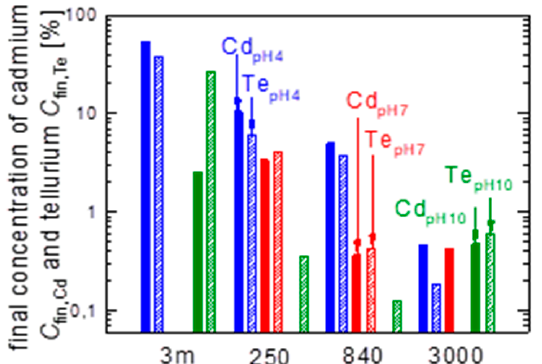
10 of 20 Figure 5. Elution of Cd pH10 and Te pH10 in solutions with pH10 out of CdTe powder and for milled module pieces. ( a ) The size dependent leaching of Cd pH10 changes when compared to the acidic elution in Figure 1. Here it holds Cd 3,m > Cd 3000 > Cd 840 ≈ Cd 250 . The Cd 3,m -value for the milled mod- ules pieces is highest. ( b ) Leaching of Te pH10 is also size dependent. However, for the powders, there is not much difference for the different particle sizes. The lines, again, represent a fit of Equa- tion (5) with the time dependence t 0 . 43. 3.4. Maximum Values after t = 83 d Figure 6 summarizes the data from Figures 3a–5b after 83 days for the maximum concentration of Cd and Te that is found in the solutions with different pH. From the Cd